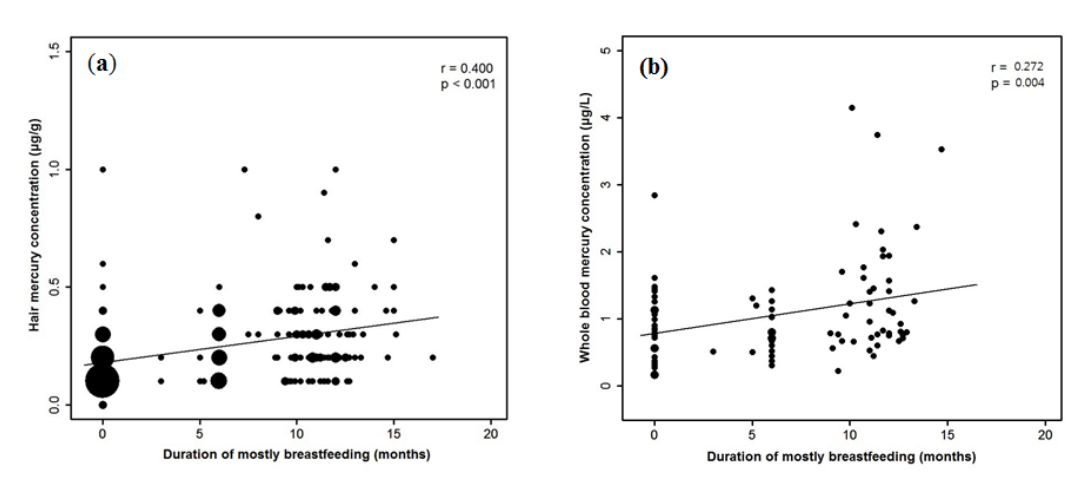
Figure S2. Correlation between duration of mostly breastfeeding and mercury content in hair ( a ), and in whole blood ( b